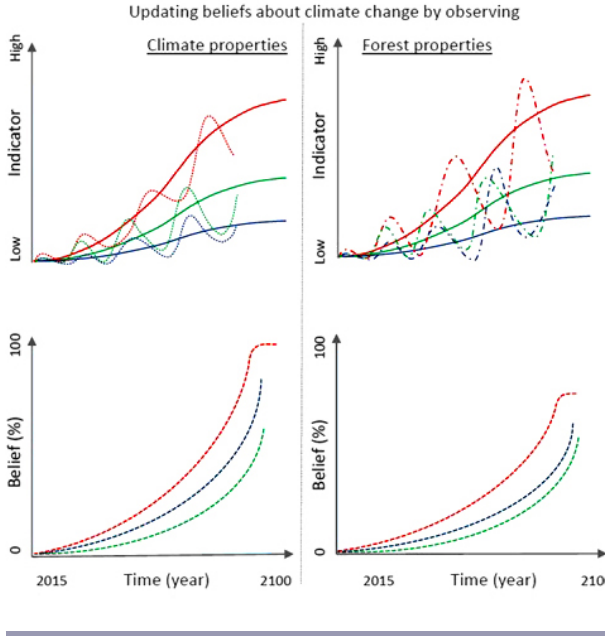
Fig. 4 . Updating beliefs about the real future development of climate change scenario, when Bayesian updating is based on the observation of different climate and forest variables drawn from 100,000 Monte Carlo samplings (source: Yousefpour et al. 2013). Red, green, and blue lines indicate high, moderate, and low change in climate, respectively (top left). Dotted lines illustrate the variation of climate variables (top left), and hyphenated lines show the variation of forest variables (top right) over time. Dashed lines show the development of beliefs on climate change scenarios based on observing climate (bottom left) or forest variables (bottom